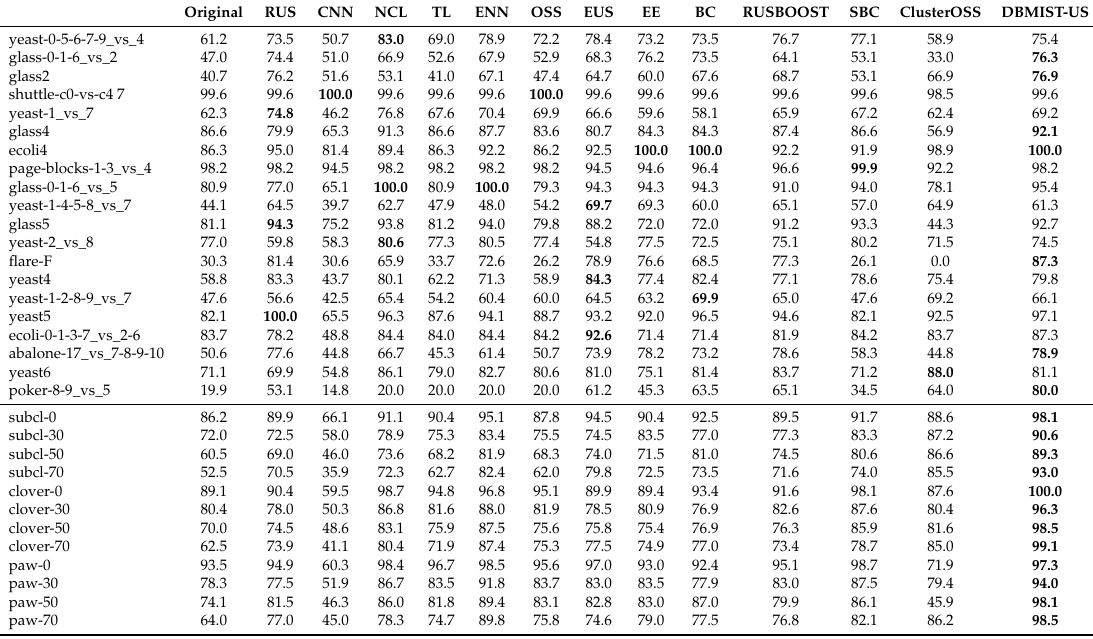
Table A1. Geometric mean results obtained with